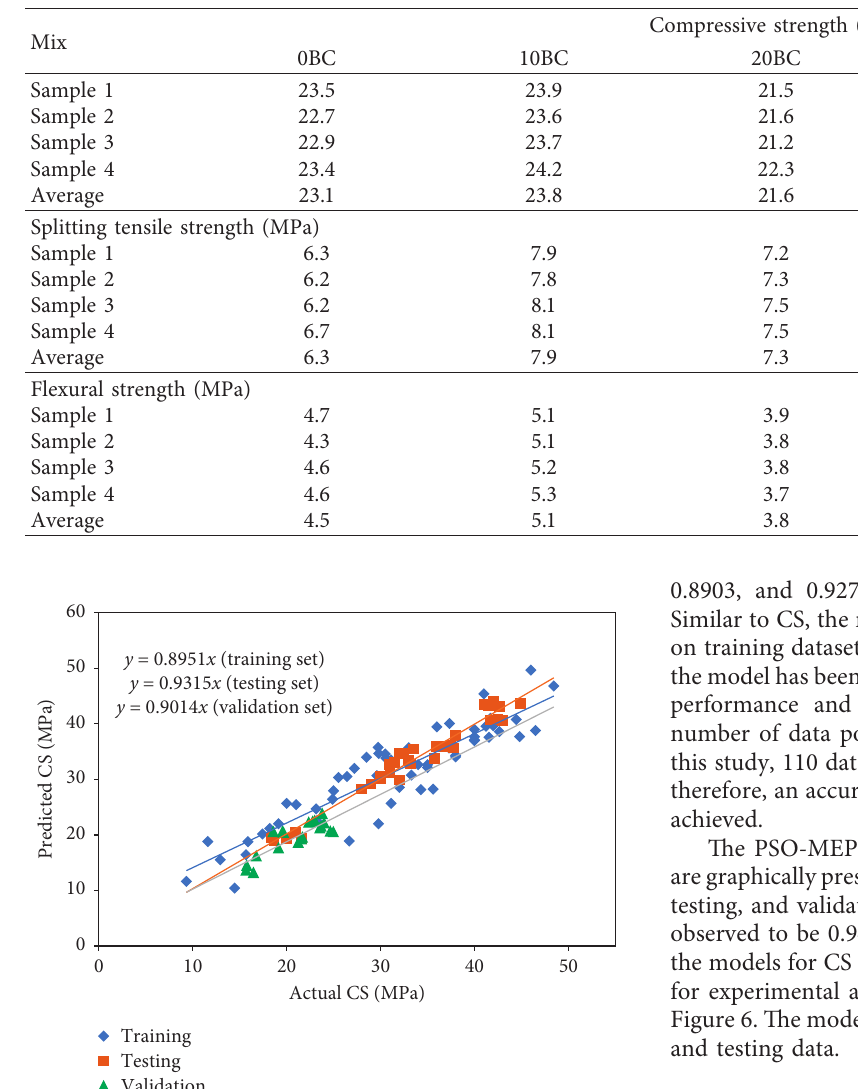
Table 5: Results of laboratory-derived mechanical properties of SCBA concrete.